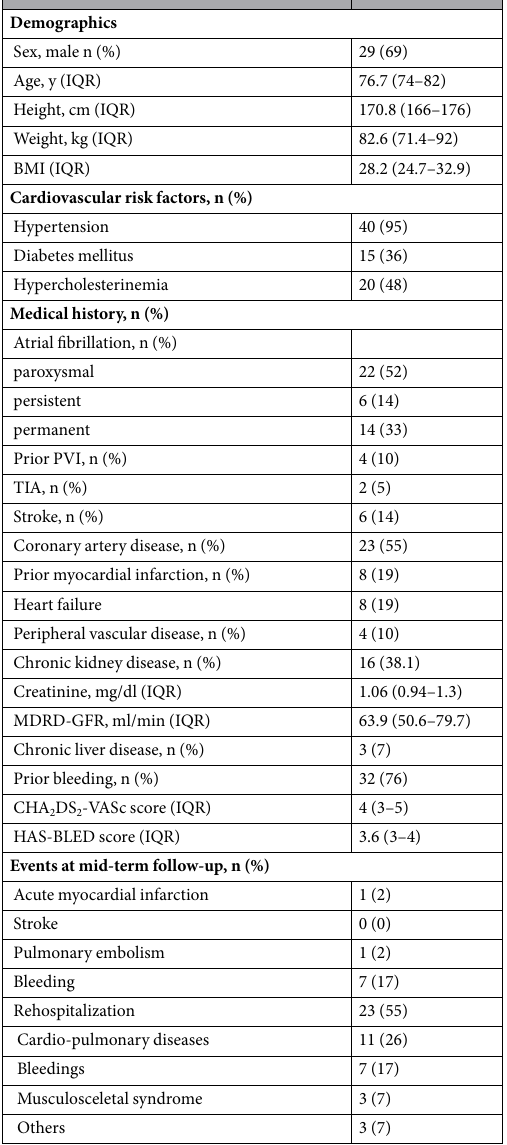
Table 1. Baseline characteristics of 42 patients with successful left atrial appendage occlusion and biomarker evaluation. Values are given as median (25 th and 75 th percentiles) or total numbers (percentage). AF = atrial fibrillation, PVI = pulmonary vein isolation, TIA = transient ischemic attack, AMI = acute myocardial